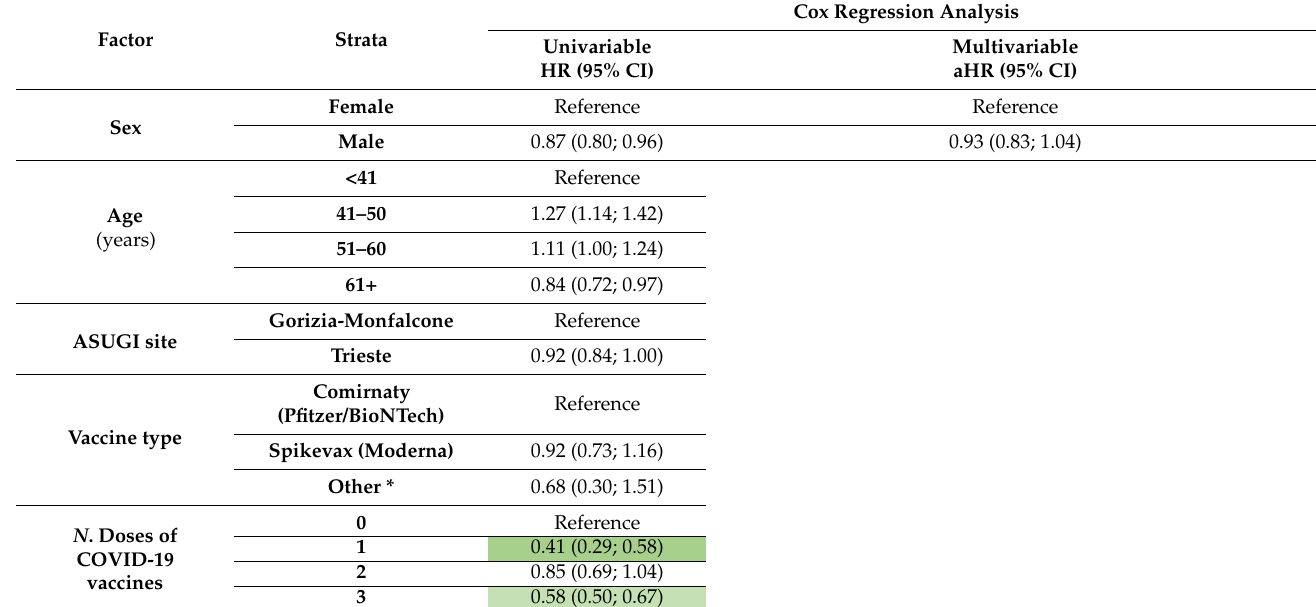
Table 4. Cox proportional regression model for the risk of primary SARS-CoV-2 infection (1 December 2021–31 May 2022). Hazard ratio unadjusted (HR) and adjusted (aHR), with 95% confidence interval (95% CI). Multivariable model fitted onto 1994 complete observations. HCWs never tested for SARS-CoV-2 during 1 January–31 May 2022 ( N = 602) were excluded from the